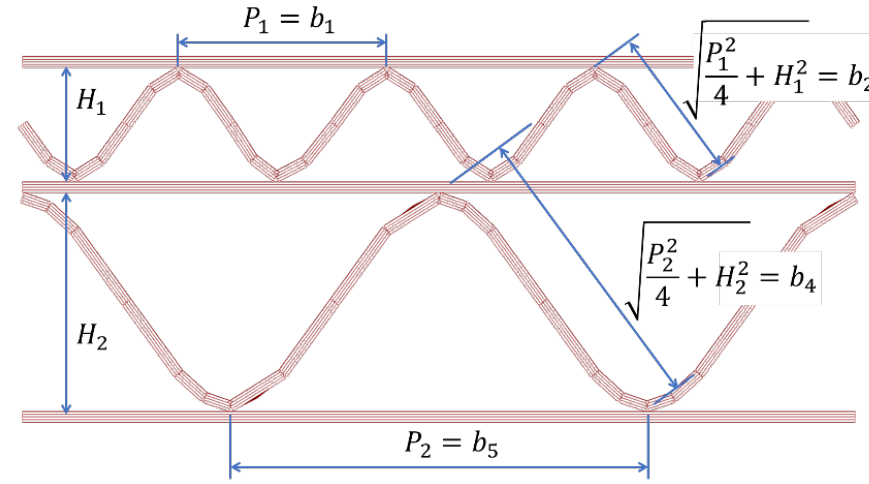
Figure 5. Cross-section of five-layer corrugated cardboard.